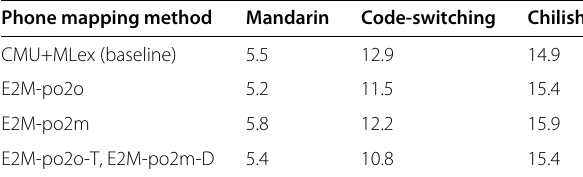
Table 3 Performance (TER%) comparison of the proposed E2M in LF-MMI based hybrid systems Phone mapping method Mandarin